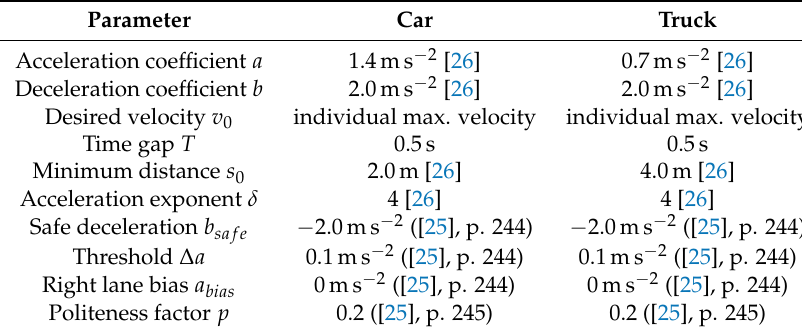
Table 1. IIDM and MOBIL